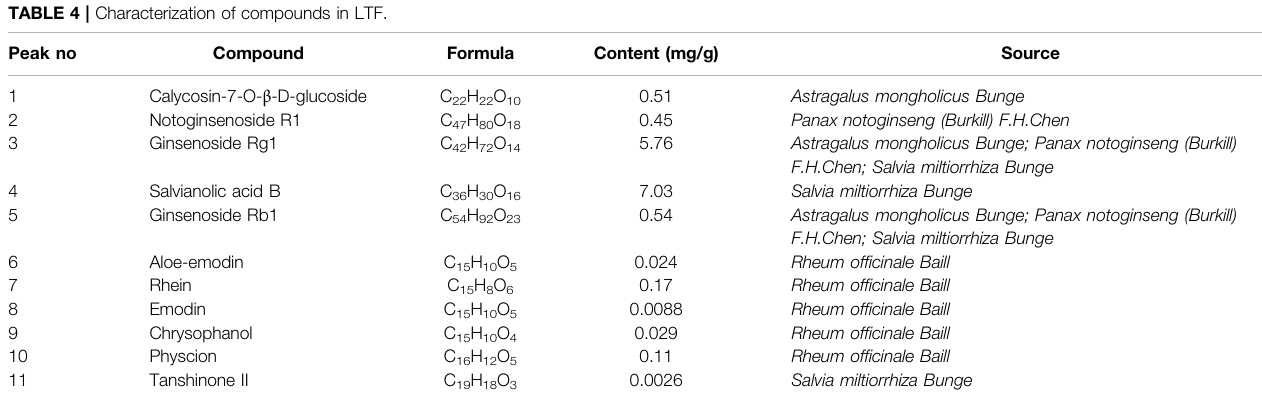
TABLE 4 | Characterization of compounds in LTF.